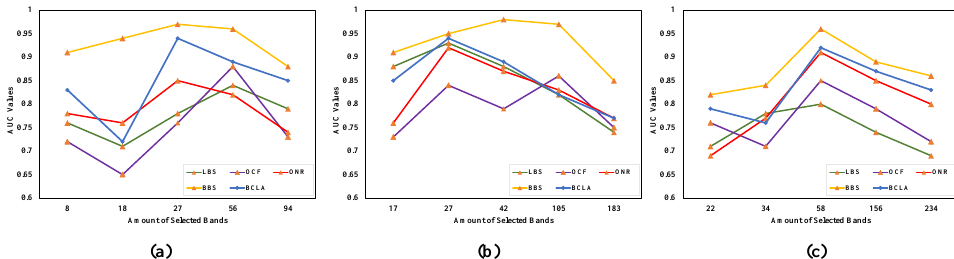
Figure 21. The relationship between the target detection performances and selected band amounts with different band selection methods for ( a ) turbid water dataset, ( b ) sea water data set, ( c ) Nano- Hyper data set. Table 8. Average execution time (in seconds) of the compared methods for all the datasets. Dataset